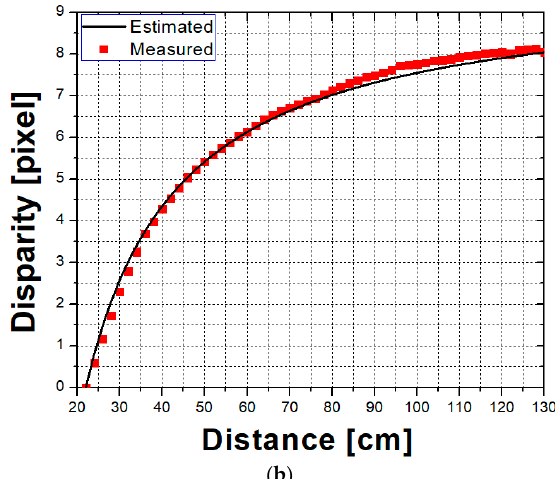
Figure 11. ( a ) Output images from the LOPA and ROPA channels, and ( b ) the measured and estimated results with disparity, according to distance.